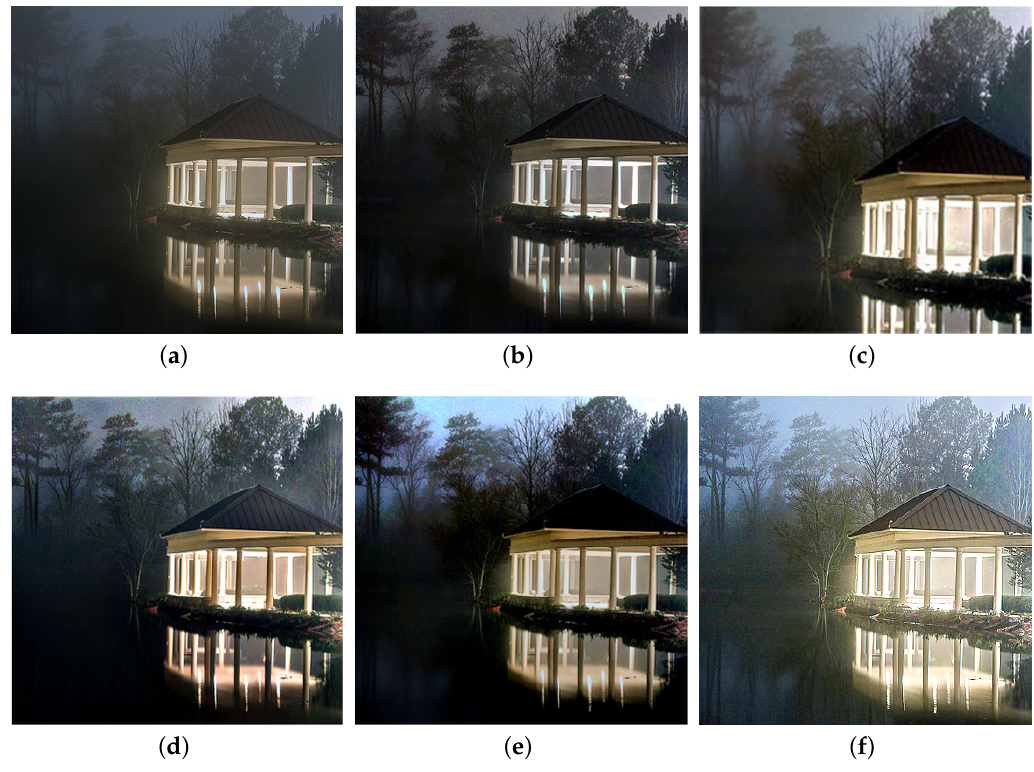
Figure 9. Comparisons with other nighttime dehazing methods on test image Lake . ( a ): the nighttime hazy image, ( b ): MRP [11] result, ( c ): HDF [41] result, ( d ): GMLC [13] result, ( e ): PAB [9] result, ( f ): SIDE result.